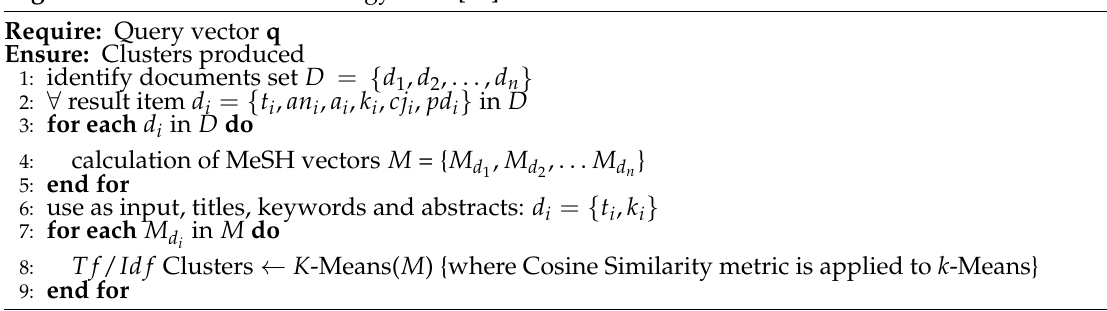
Algorithm 1 Baseline methodology from [25].